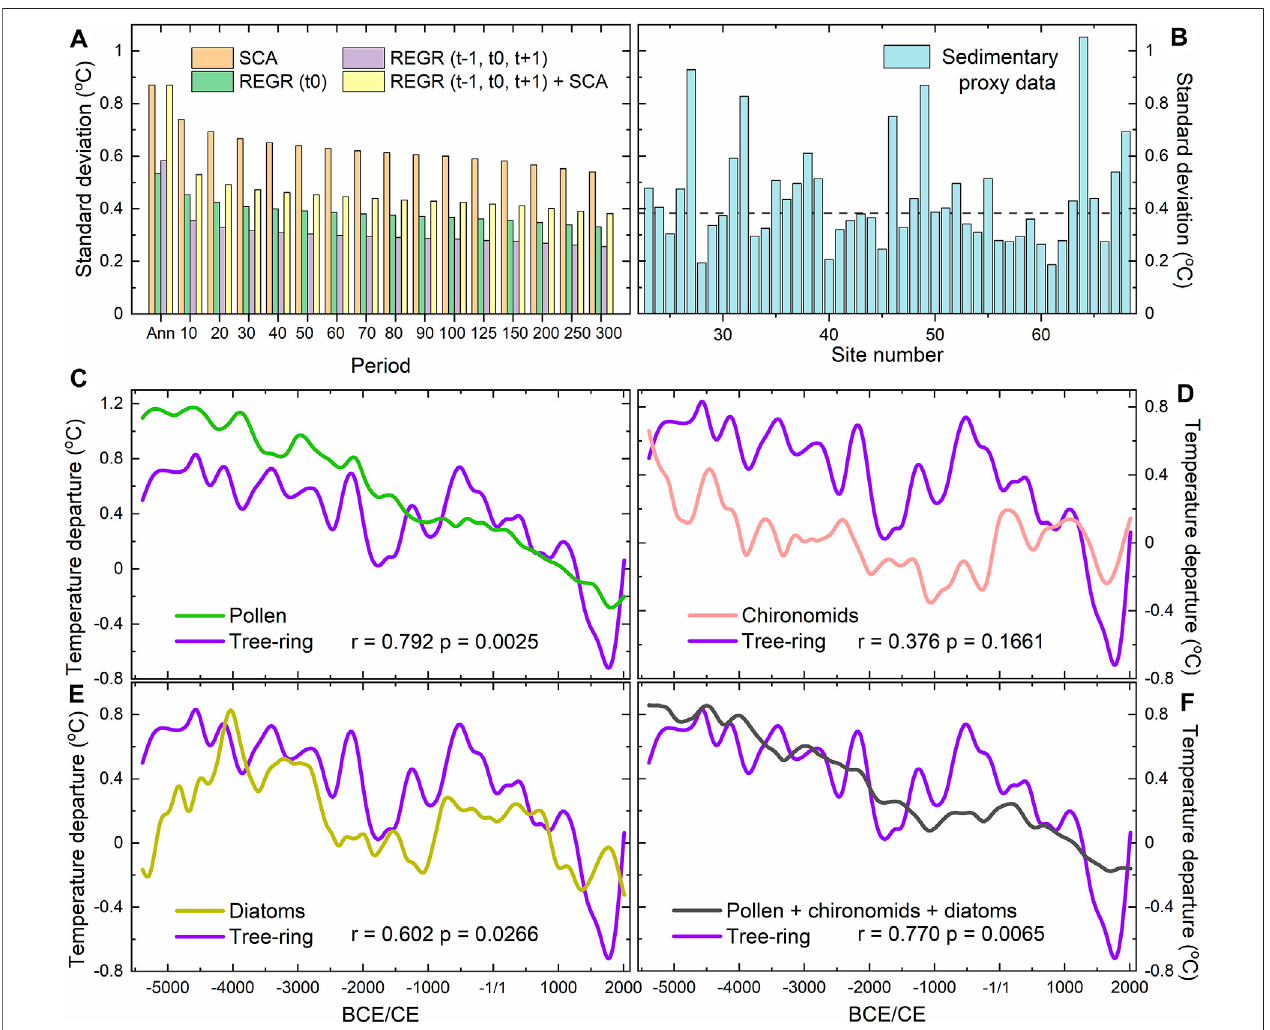
FIGURE6| Temperature variability. (A) Standard deviationsoftemperaturesinferred from theminimum bluechannellightintensity ofsubfossilwood (BI)based on linearscaling(SCA)andregression(REGR)methodsand (B) fromFennoscandiansedimentaryproxyrecords(Sundqvistetal.,2014)(see SupplementaryTableS2 for site numbers)calculated between 117and 1811 CE forboth types (A,B) ofproxy records. The period indicates therigidity ofspline function inyears used tosmooth the tree-ring records as low-pass fi lter and “ Ann ” stands for annual, un fi ltered data. Regression models explaining the temperature used tree-ring values in concurrent ( t ), previous ( t − 1), and forthcoming ( t + 1) years. The horizontal dashed line marks the median level of standard deviations for sedimentary records. (C – F) Long-term temperature comparisons of tree-ring (this study) and pollen (C) , chironomid (D) , diatom (E,F) mean (pollen, chironomids, and diatoms) evidence on centennial